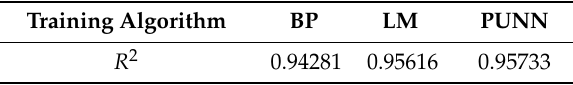
Table 2. R 2 of the BP, LM, and PUNN algorithm [37].